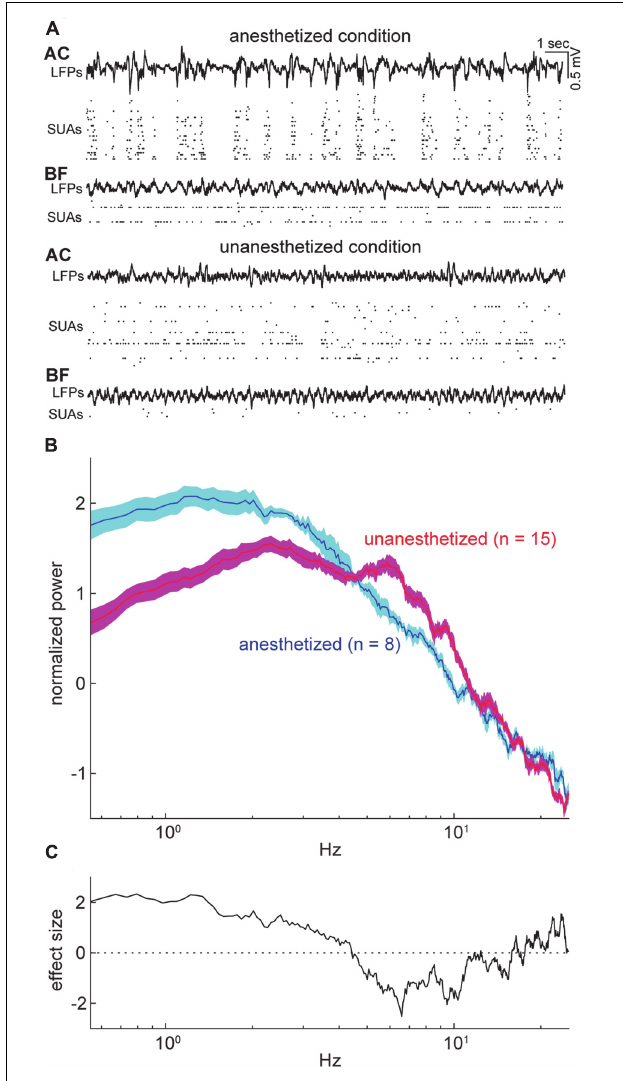
FIGURE 2 | Example simultaneous recording and cortical states during the period of spontaneous activity under anesthetized and unanesthetized conditions. (A) Simultaneous recording from the auditory cortex (AC) and basal forebrain (BF) under anesthetized (top) and unanesthetized conditions (bottom), with displaying local field potentials (LFPs) and single-unit activities (SUAs) in both areas. (B) Normalized ( Z scored) power spectral density from spontaneous LFPs in the AC for each experimental condition ( N anesthetized = 8; N unanesthetized = 15). Error indicates SEM. (C) Effect size of difference in power spectral density in (B) . As expected, the unanesthetized condition was characterized by smaller delta ( ≤ 4 Hz) and larger theta (6–10 Hz) components compared to those in the anesthetized condition, indicating that two experimental conditions represent different brain